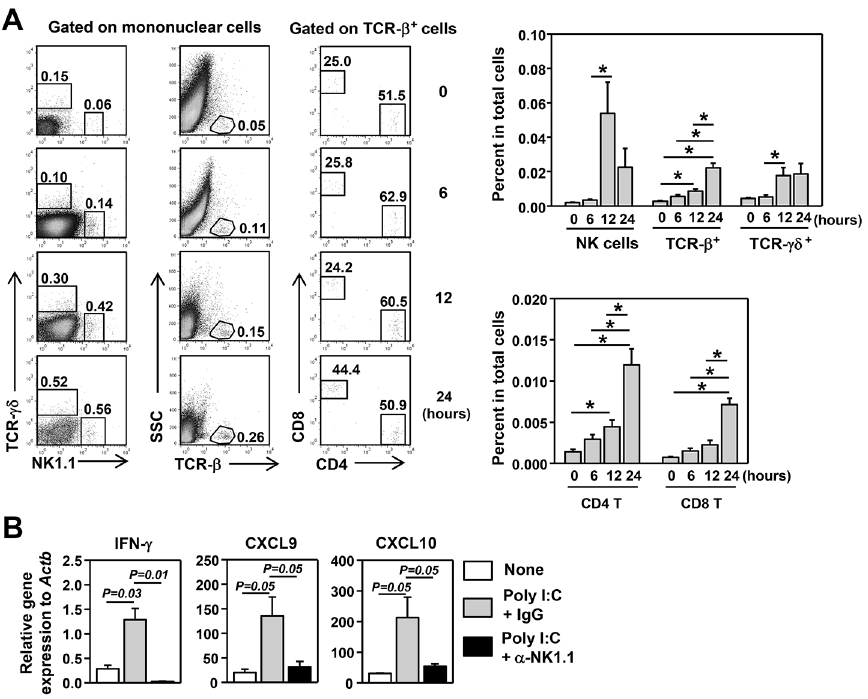
Figure 3. NK cells contribute to the early up-regulation of CXCR3 ligands induced by poly I:C. (A) C57BL/6 mice were treated with poly I:C by for the indicated amount of time. Left panels, surface staining for immune cell populations in the submandibular glands, with the gating indicated above the plots. Right panels, Percentage of NK1.1 + TCR-β + , TCR-γδ + , CD4 + and CD8 + T cells among total submandibular gland cells. All data are the average of or representative of 5 individual mice (2-3 mice per experiment, total 2 independent experiments). (B) RAG-1 -/- mice were pre-treated with anti-NK1.1 antibody 2 days prior to poly I:C injection. Submandibular glands were harvested 6 hours after poly I:C injection and measured for gene expression by real time PCR. Data are from analyses of 4 individual mice (2 mice per experiment, total 2 independent experiments). doi: